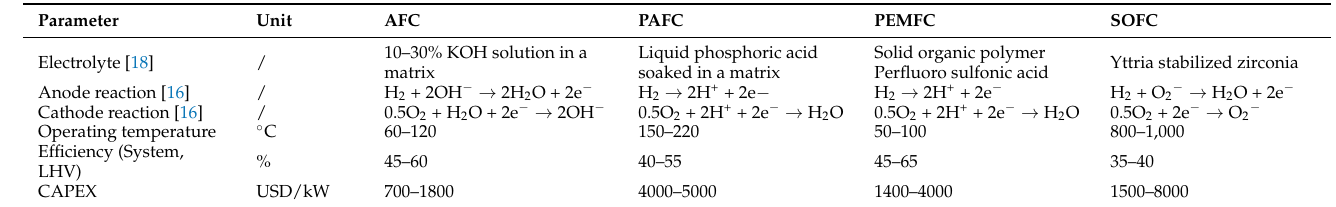
Table 2. Technical characteristics and selected parameters of AFC, PAFC, PEMFC, and SOFC technol- ogy according to the recent literature [9,17,19]. Abbreviations: AFC = alkaline fuel cell; PAFC = phos- phoric acid fuel cell; PEMFC = polymer electrolyte membrane fuel cell; SOFC = solid oxide fuel cell. If not specifically indicated, the values indicate representative values in line with